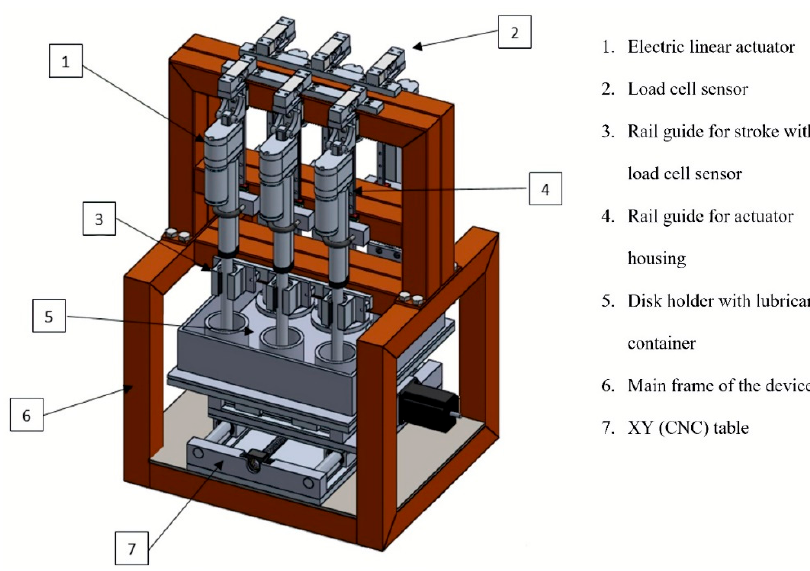
Figure 1. Schematic diagram showing a 3D model of the CNC-POD.